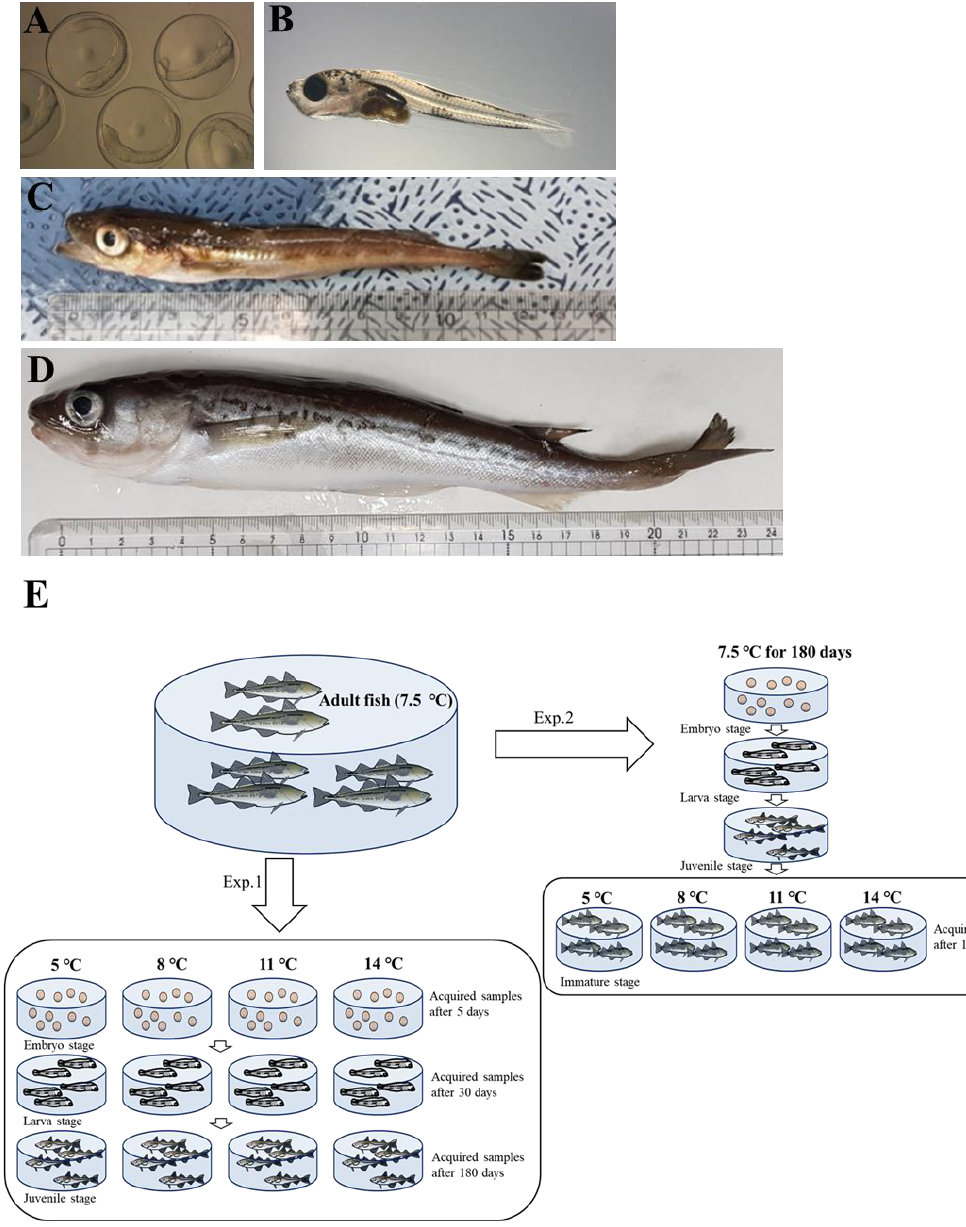
Figure 1. Walleye pollocks used in the experiment. ( A ) Embryos (2.5 Χ 125 h after fertilization); ( B ) Larvae (1.6 Χ ; 30 days after hatching); ( C ) Juvenile fish (8–12 cm in length, approximately 180 days);